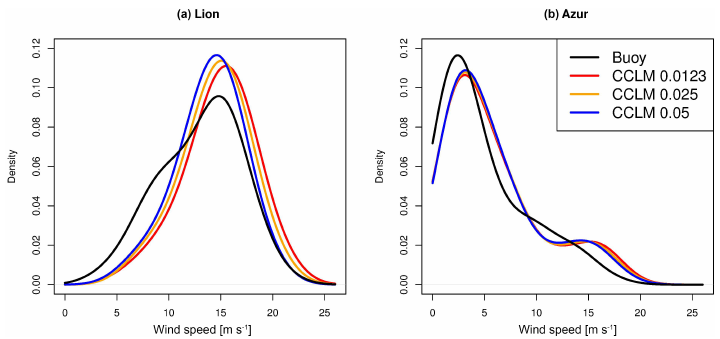
Figure 5. 10m wind speed density distribution at Gulf of Lion buoy location (a) and Azur buoy location (b) .